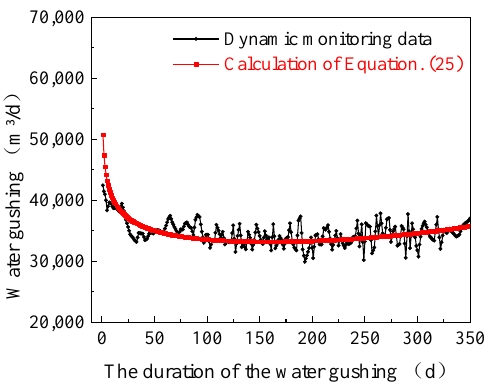
Figure 9. Comparison of calculated results with dynamic monitoring records.